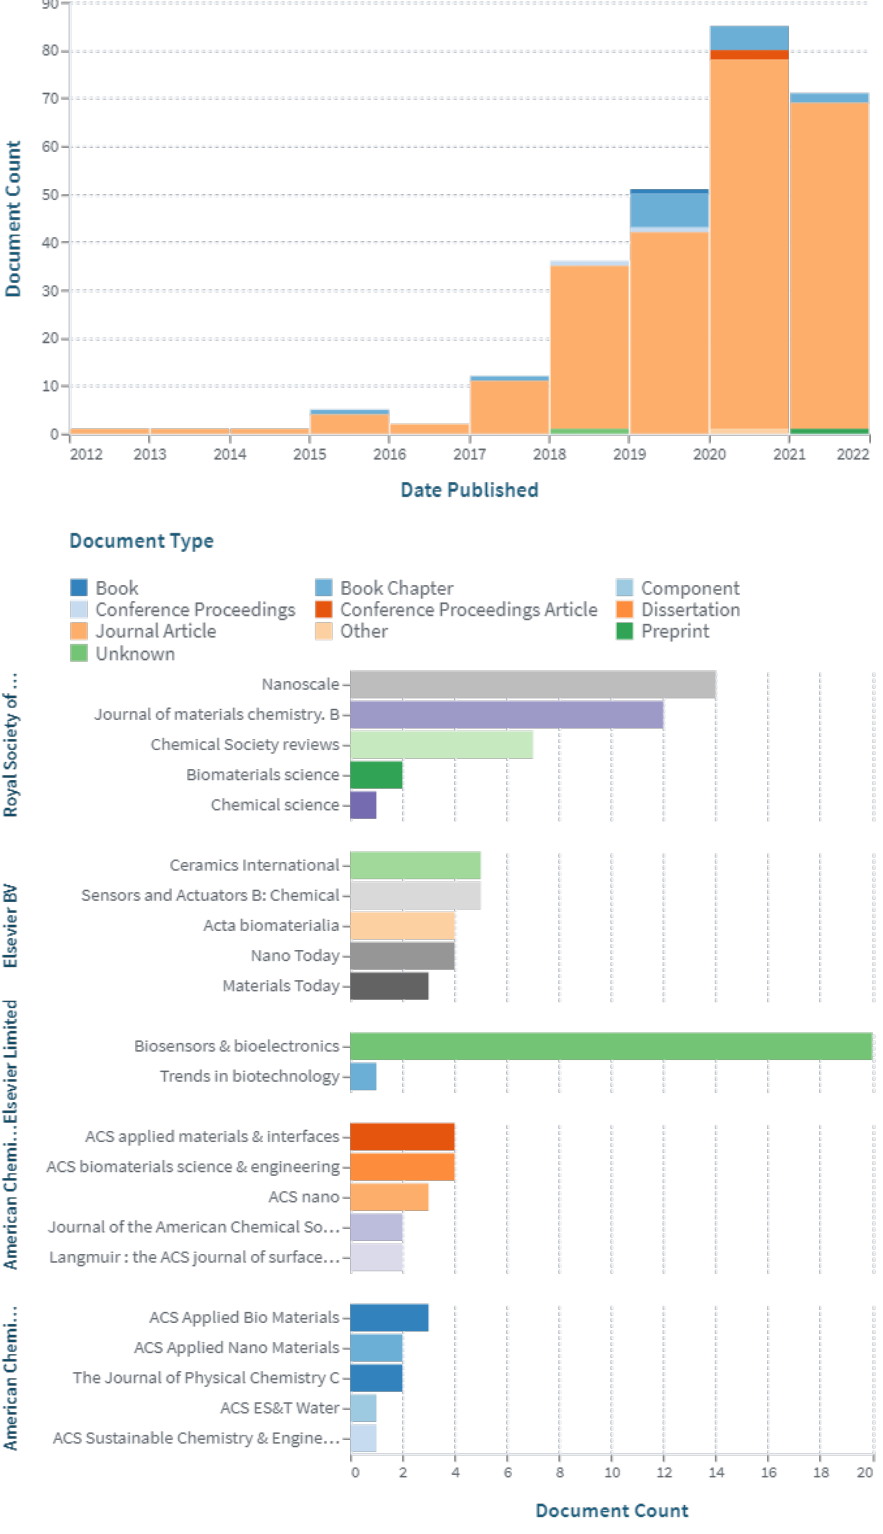
Figure 11. Trends related to scholarly works published using keywords “MXenes” and “biomedical” and journal details using lens.org, respectively. There is an evident increase in the number of published works each year.